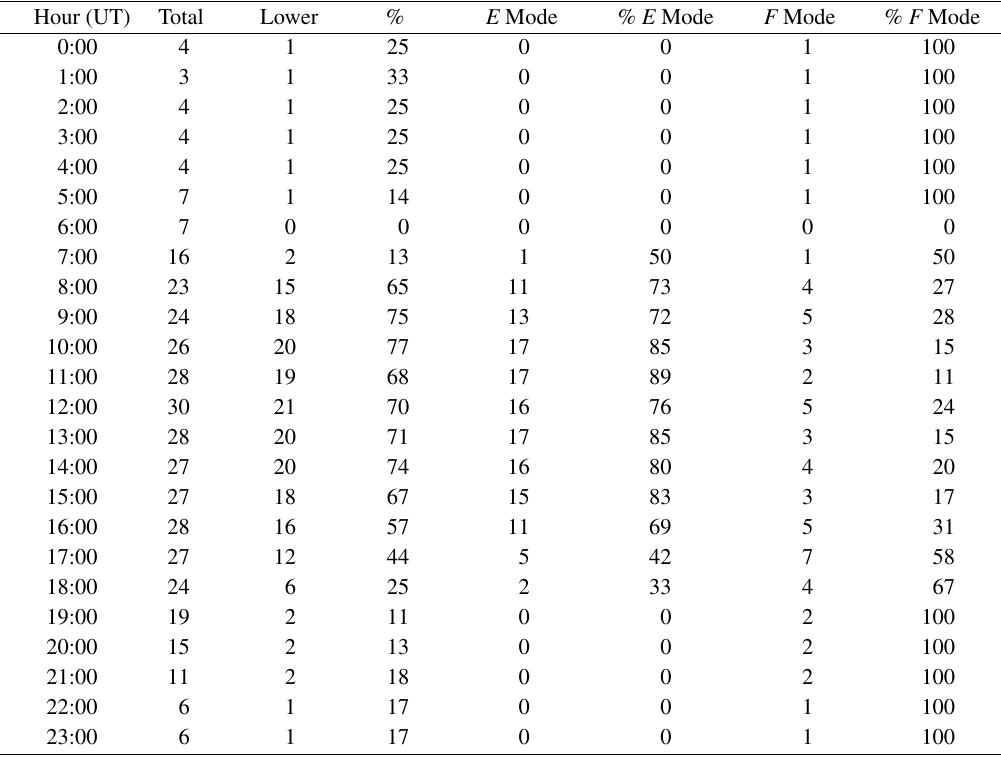
Table I. Number of lower conditions cases which arrive at the